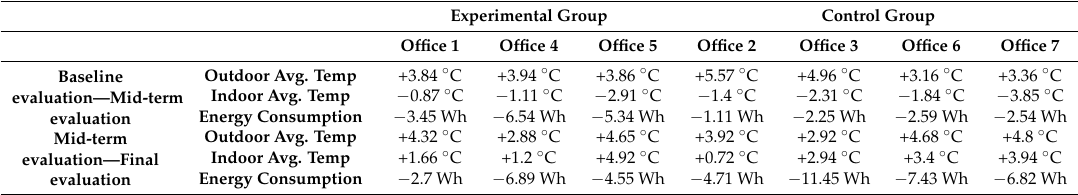
Table 8. Differences in temperature and energy consumption between periods.